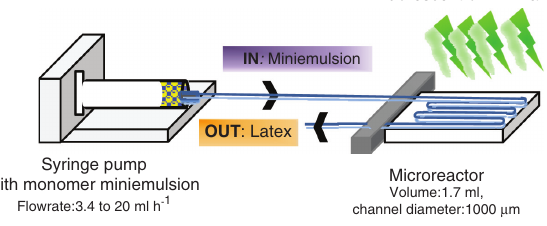
Figure 1 Experimental microreactor